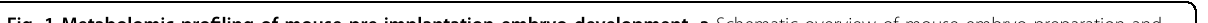
Fig. 1 Metabolomic pro fi ling of mouse pre-implantation embryo development. a Schematic overview of mouse embryo preparation and metabolome pro fi ling during mouse pre-implantation embryo development. b Venn diagram showing the overlap among metabolites across all stages. The number of signi fi cantly abundant metabolites is shown in red. c Alluvial plots of the global dynamics of high, intermediate, and low metabolites based on their levels during early embryo development. d UMAP analysis. Metabolites marked with the same color represent six replicates of the same stage. e Heatmap of metabolite dynamics during mouse embryo development, classi fi ed according to metabolic pathways. f KEGG analysis of abundant metabolites in each